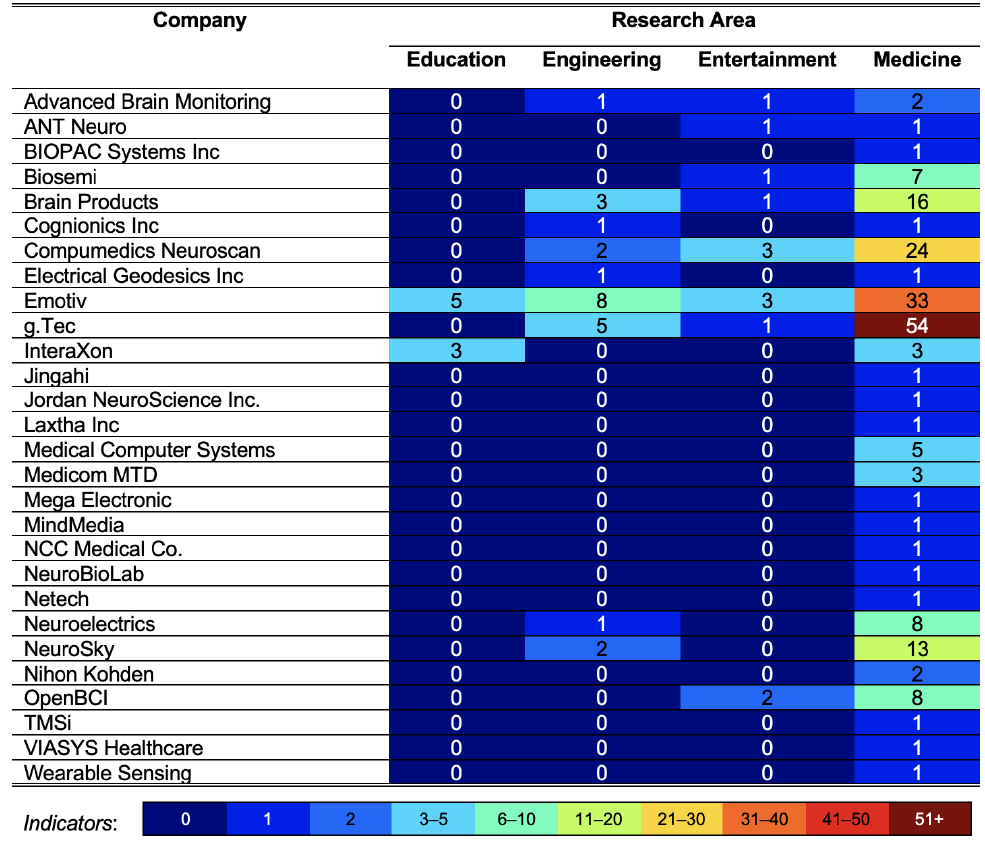
Figure 5. Mapping between the companies and research areas identified in the selected articles. Different colors represent the proportions of the reviewed studies, as shown by the